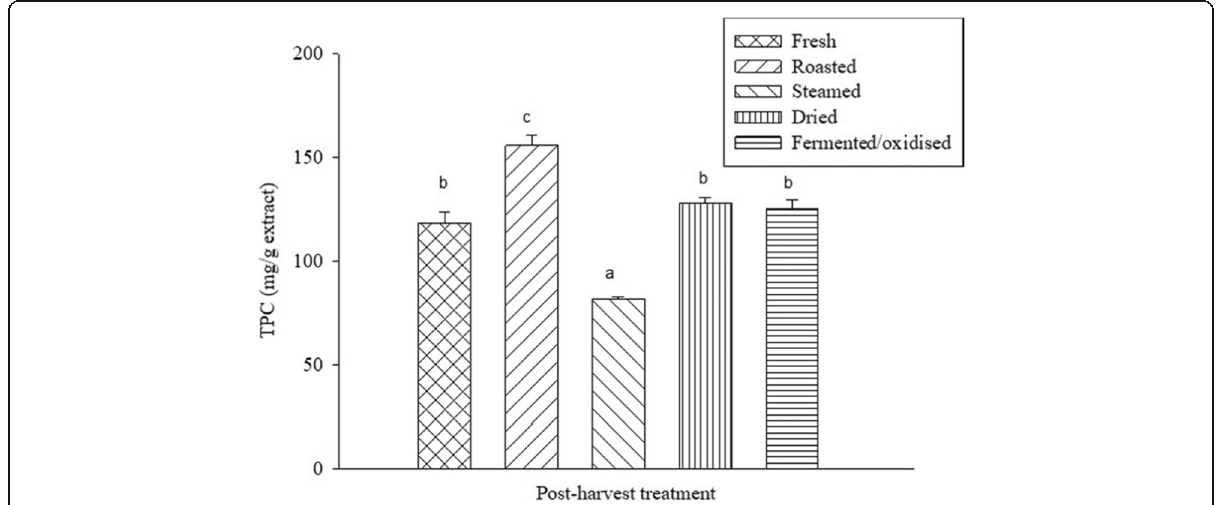
Fig. 2 Total phenolic content in fresh and processed leaf extracts of Moringa